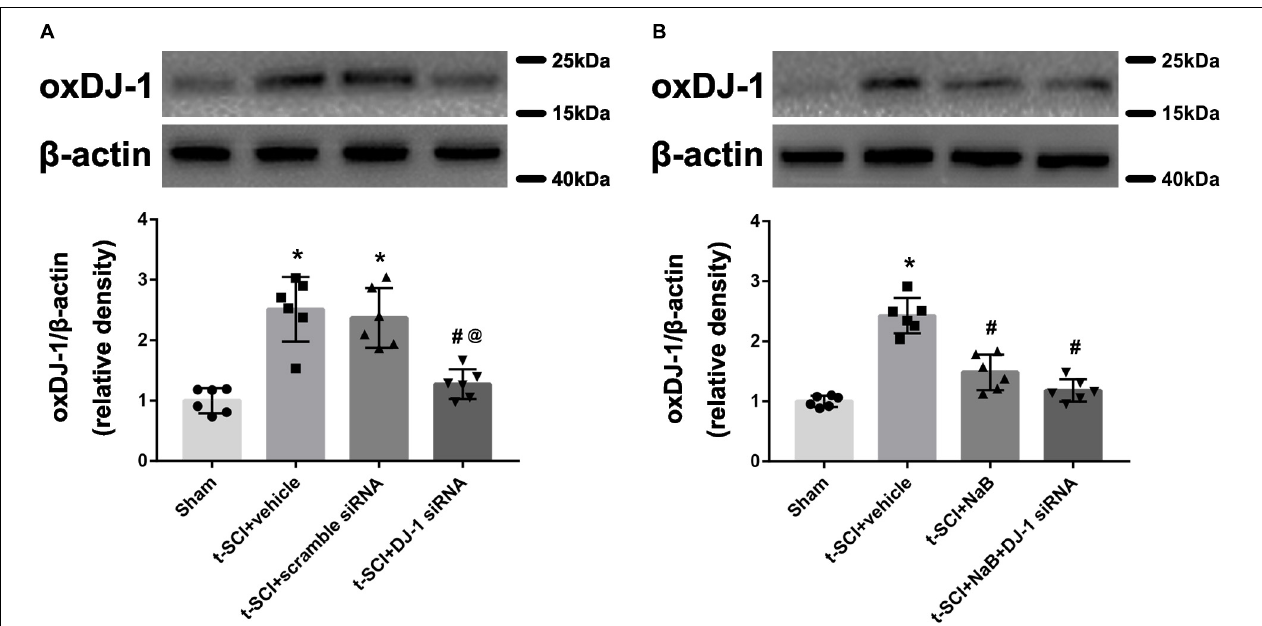
FIGURE 6 | Representative Western blots showing the protein levels in each group at 24 h post-injury. The expression level of oxDJ-1 was significantly increased after t-SCI, treatment with DJ-1 siRNA significantly decreased the level of oxDJ-1, and injection of scramble siRNA did not change the expression level of oxDJ-1 (A) . Treatment with NaB alone or combined with DJ-1 siRNA significantly decreased the level of oxDJ-1. There were no differences in oxDJ-1 levels between the t-SCI + NaB and t-SCI + NaB + DJ-1 siRNA groups (B) . N = 6 for each group. Data is expressed as mean ± SD and analyzed by one-way ANOVA and Bonferroni’s post hoc multiple comparisons test. ∗ p < 0.05 versus sham; # p < 0.05 versus t-SCI + vehicle; @ p < 0.05 versus t-SCI + scramble